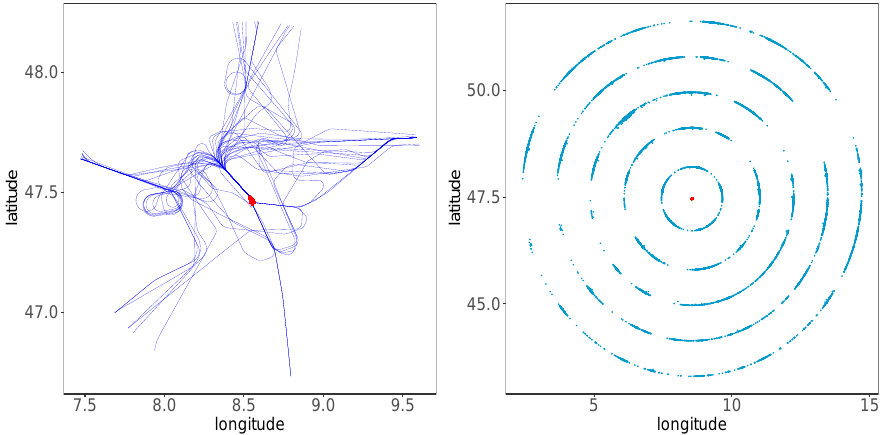
Figure 1. (Left) Sixty sample trajectories approaching Zurich Airport between 5 October 2019 and 31 October 2019, used for landing time prediction in this study. (Right) Entry points of aircraft when 45, 100, 150, 200, and 250 nautical miles away from the runways. The red point in the middle denotes the reference point 47.45 latitude and 8.56 longitude of Zurich